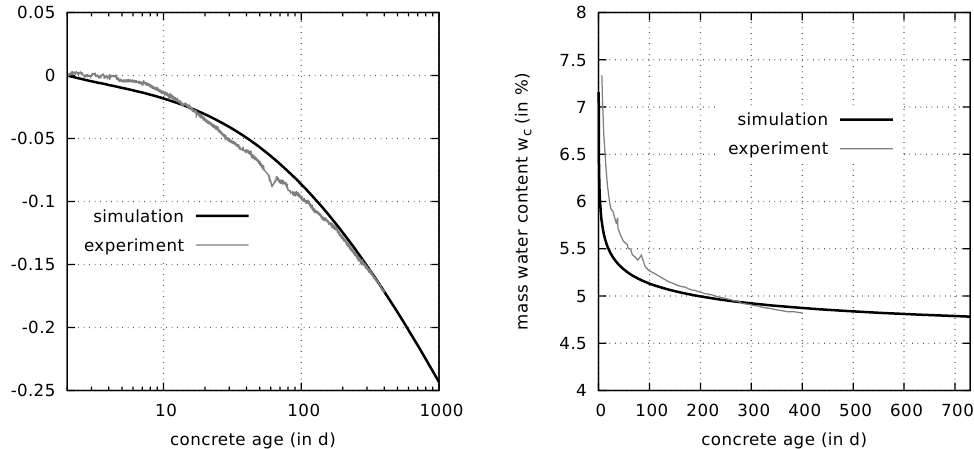
Figure 6. Comparison of measured [7] and computed evolution of the autogenous shrinkage strain ( left ) and of the mass water content in a sealed specimen ( right